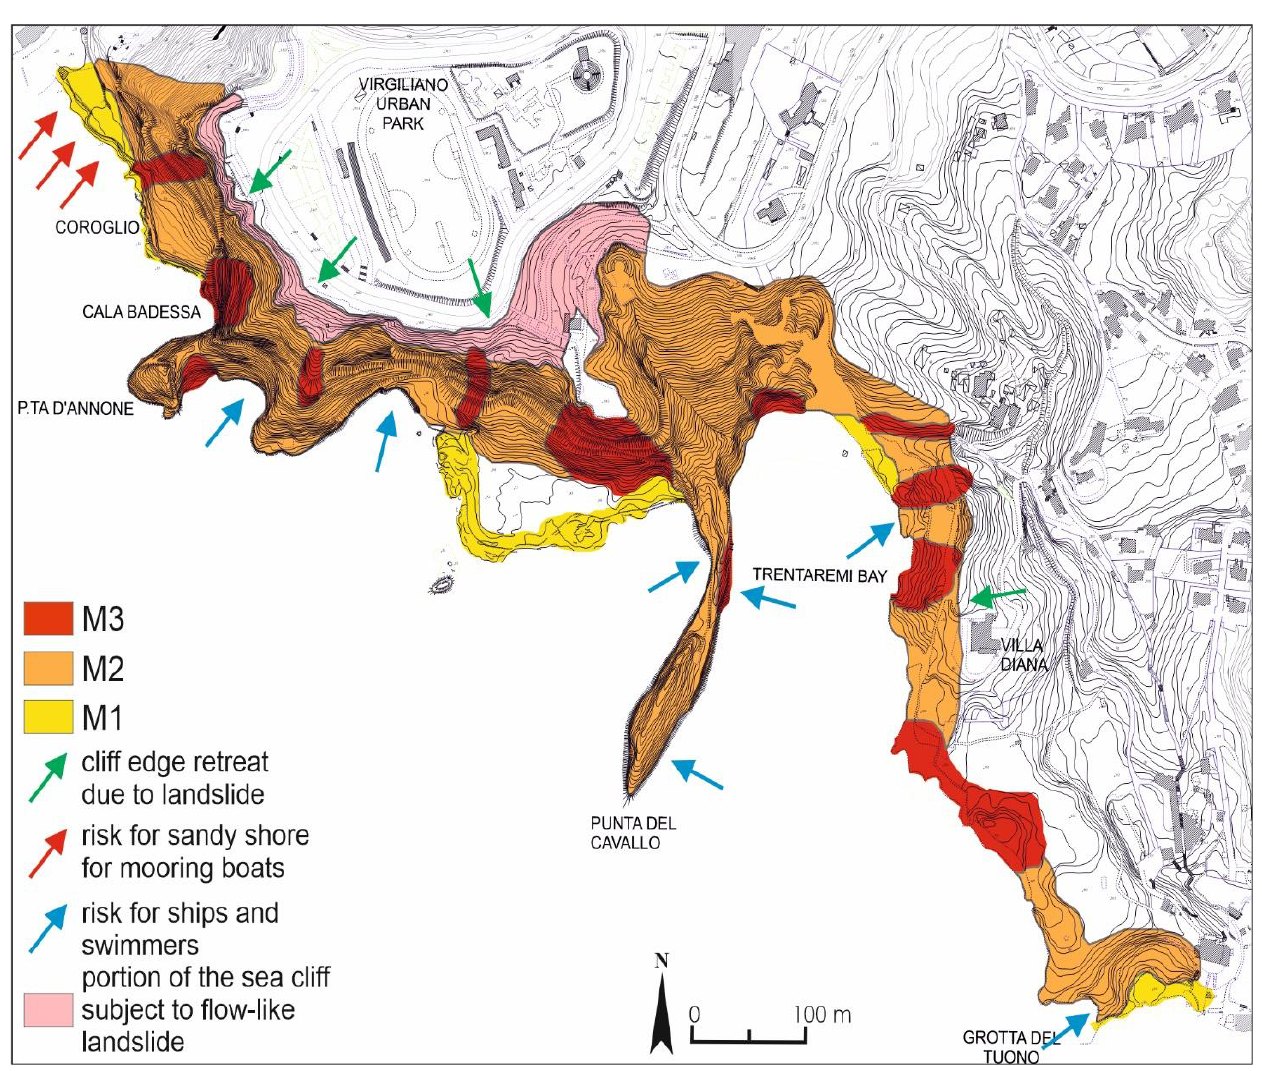
Figure 12. Geomorphological zonation of landslide magnitude along the Coroglio-Trentaremi sea cliff. M3: high magnitude landslide (hundreds to thousands of cubic meters involved); M2: moderate magnitude landslide (tens of cubic meters involved); M1: low magnitude landslide (few cubic meters involved). Arrows indicate areas subject to risk due to cliff edge retreat (green arrows), to the presence of sandy shore for mooring boats (red arrows) and to the presence of ships and swimmers (blue arrows).